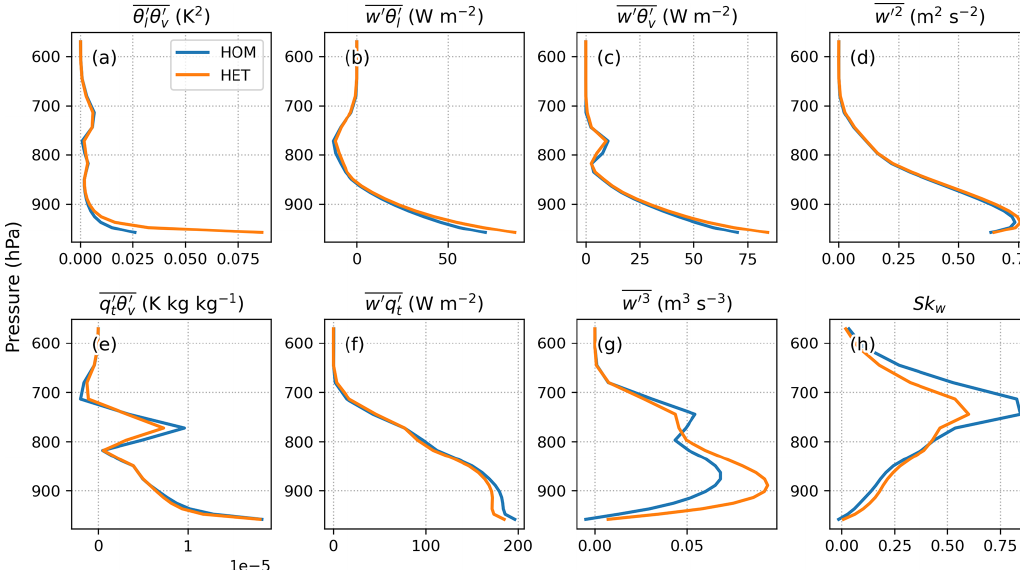
Figure 11. Same as Fig. 7, except for non-precipitating cloudy days.